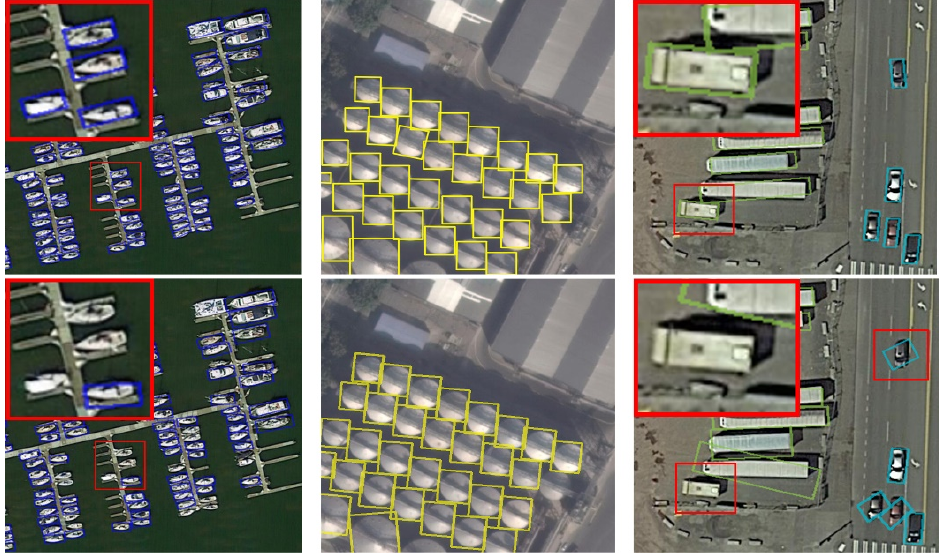
Figure 9. DOTA dataset detection results (the first line is the proposed method, the second line is the RetinaNet